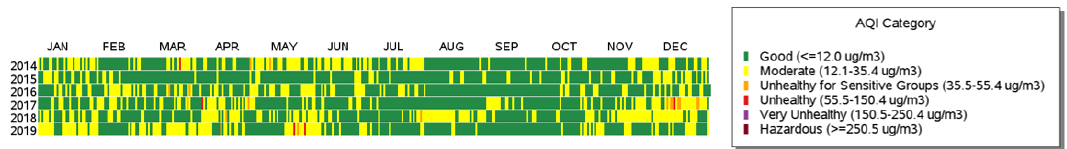
Figure 2. Different PM concentration days in El Paso during 2014–2019